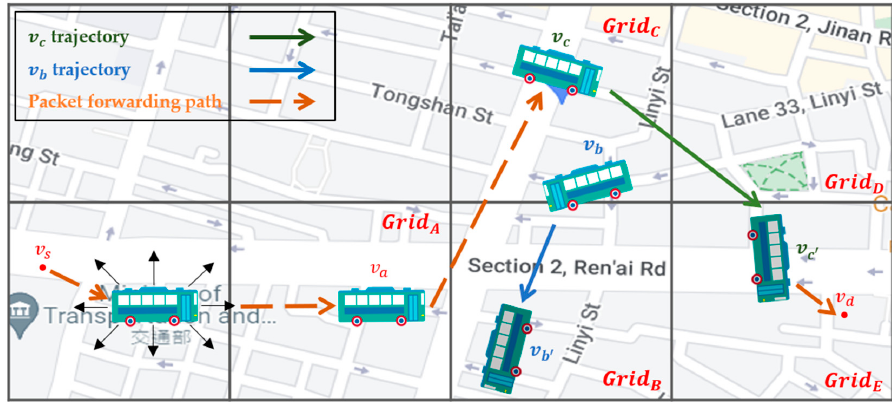
Figure 2. The two-hop directionality for the intragrid routing of SD-QGrid.